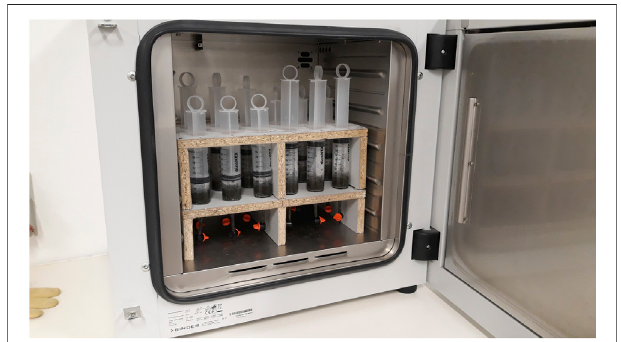
FIGURE 1 | Laboratory tests using 100 ml syringes.